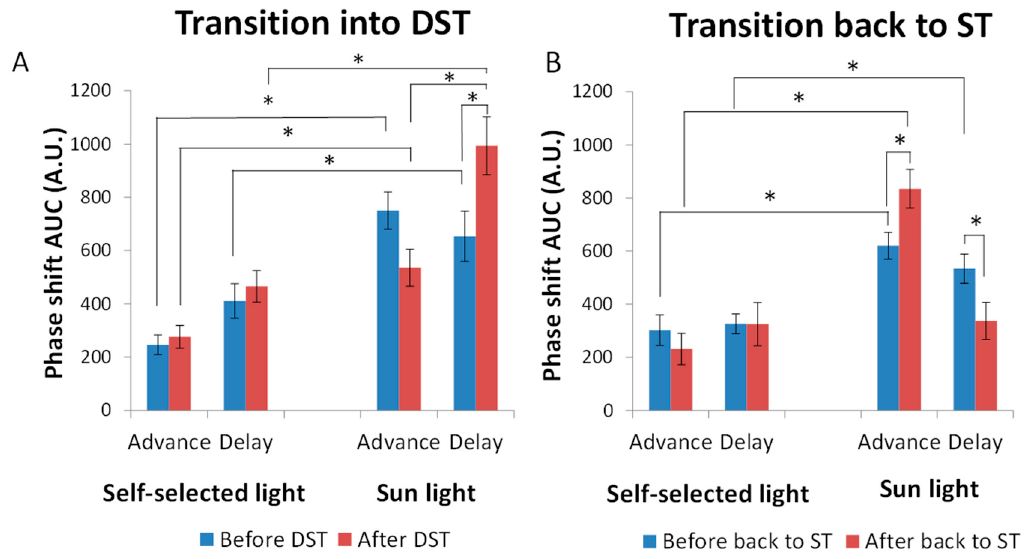
Figure 6. Cumulative average theoretical phase shifts (advances or delays) according to the phase response curve to light [51] ( n = 8) before (blue) and after (red) the transition to DST ( A ) and after transitioning back to ST ( B ), centering the circadian phase as 0 h on TM5 for WT of each participant ( n = 8) either for self-selected light or for sunlight. Data are expressed as the mean area under the curve ± SEM. * indicates p < 0.05 (repeated measures ANOVA, Bonferroni post-hoc comparisons). After the clock change (Figure 6A, red), differences in phase advances between per- light vs. 653 ± 94 A.U. for sunlight, p < 0.05, F = 5.173, DF = 1). However, sunlight almost